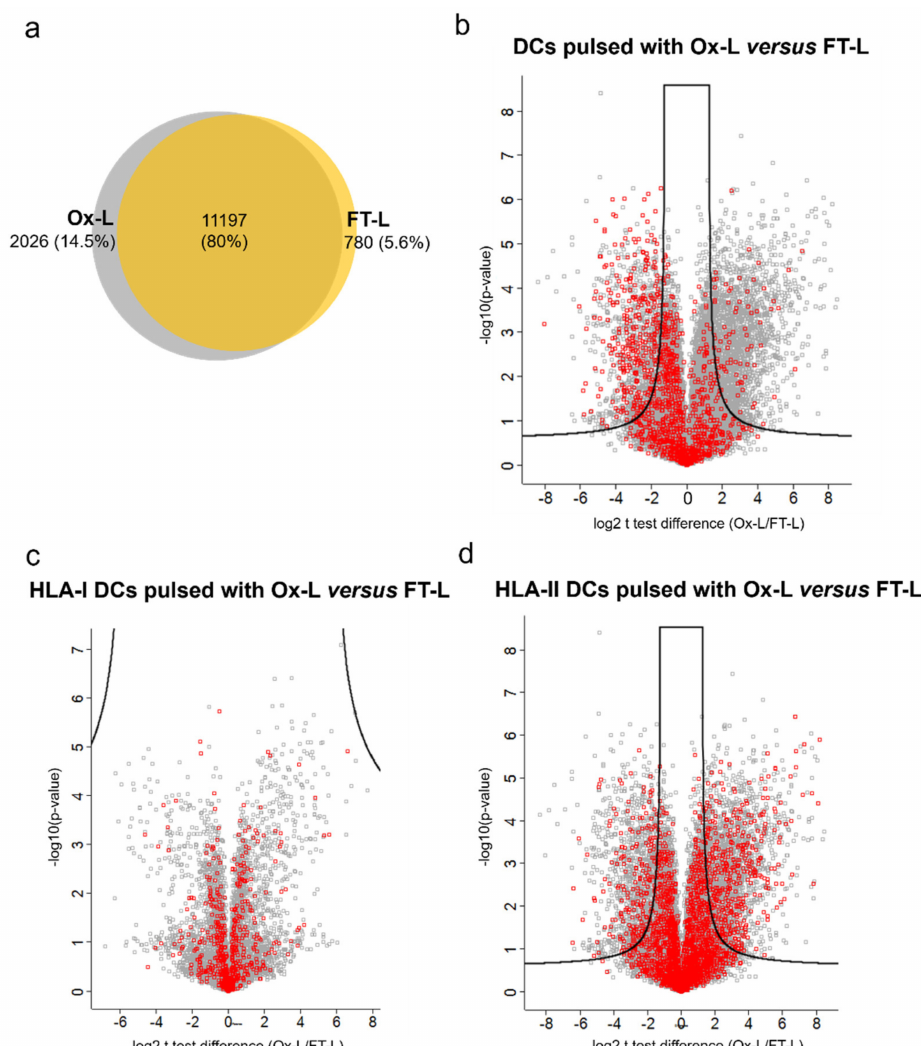
Figure 6. HOCl antigen treatment significantly increases HLA class-II antigen presentation in mo-DCs. Samples were prepared and analyzed as reported in Figure 5. ( a ) Venn diagram reporting the overlap between the number of unique peptides isolated from HLA-II complexes from mo-DCs loaded with the indicated antigen source. ( b ) Volcano plot representation of t test analysis comparing HLA-II peptide intensities in mo-DCs loaded with Ox-L versus FT-L; each point represent one peptide plotted by log2 fold change versus minus logarithm of the q -value (Benjamini-Hochberg corrected p -value), with a cuto ff value of 0.05; red squares indicate peptide containing ox-Met residues. ( c , d ) Volcano plot representation of t test analysis comparing HLA-I ( c ) and HLA-II ( d ) peptide intensities in mo-DCs loaded with Ox-L versus FT-L; each point represent one peptide plotted by log2 fold change versus minus logarithm of the q -value (Benjamini-Hochberg corrected p -value), with a cuto ff value of 0.05; red squares indicate peptides from putative proteins significantly upregulated in Ox-L compared to FT-L (from Figure